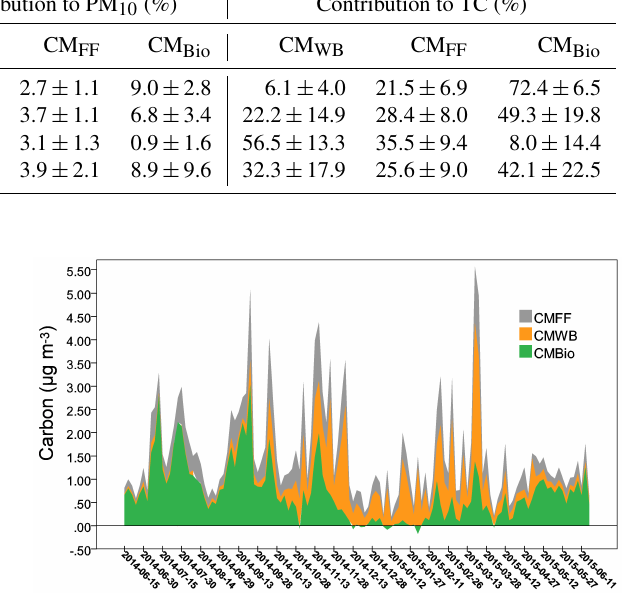
Figure 4. Aethalometer model source apportionment of total car- bon from the Vavihill measurement station, June 2014–June 2015. N =